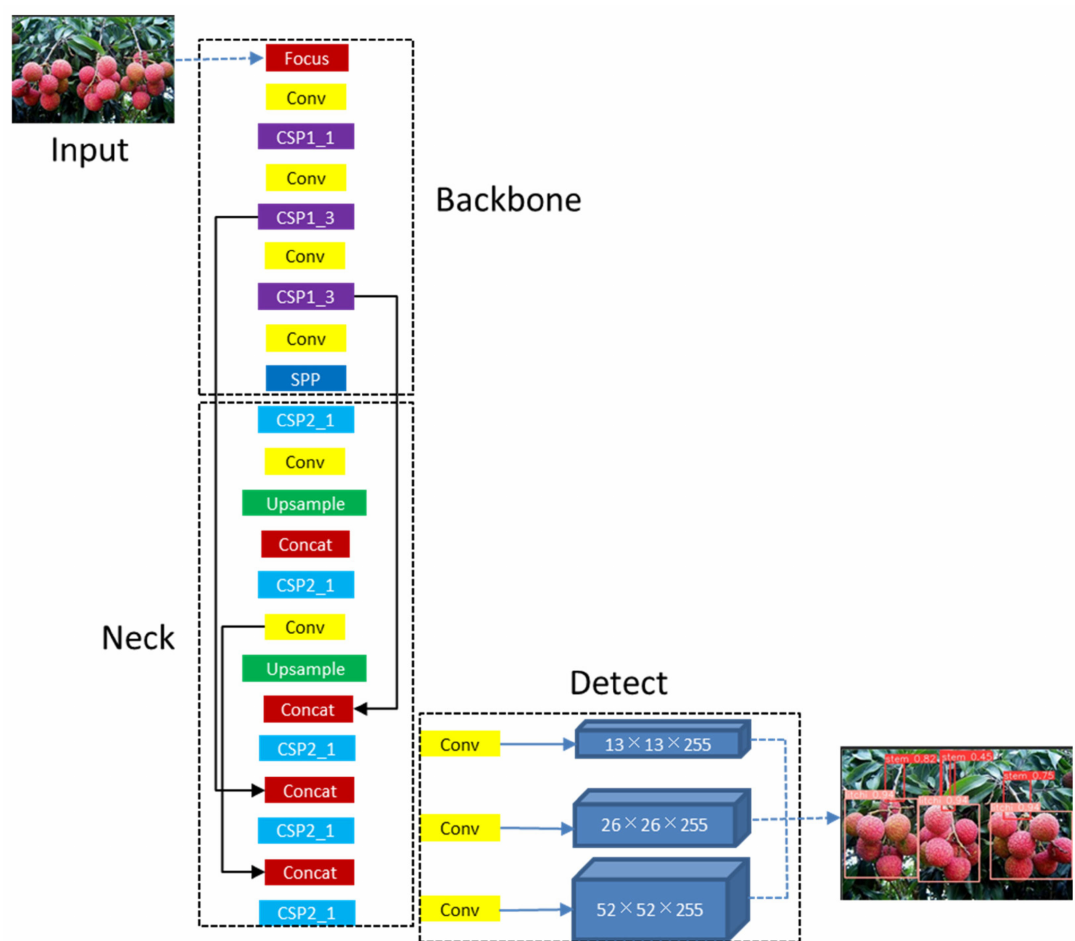
Figure 3. The network structure of